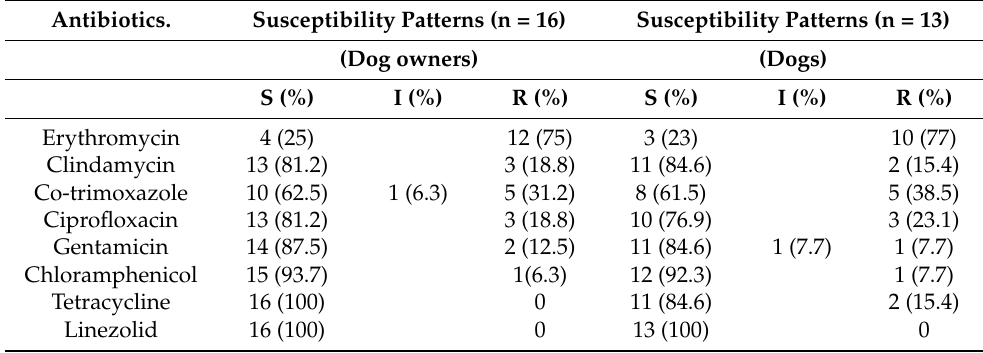
Table 3. Antibiotic susceptibility pattern of MRCoNS in dog owners and dogs.